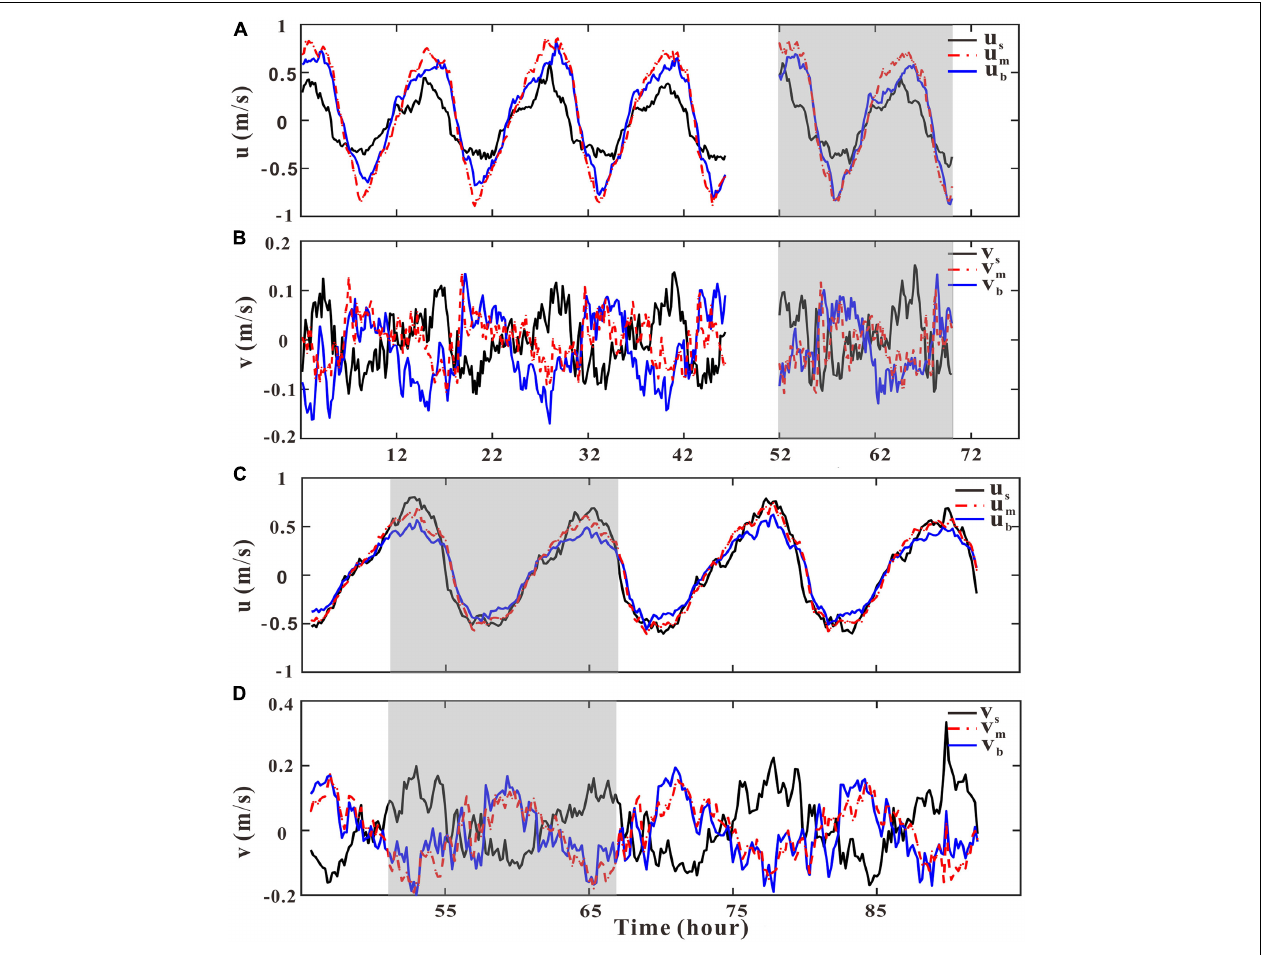
FIGURE 6 | Time series of u and v at the upper (0.75–0.85 h), the lower (0.15–0.25 h), and the mid (0.4–0.5 h) water column at GJ-01 (A,B) and GJ-02 (C,D) . The near-surface, mid, and near-bottom current velocities are shown in black, red, and blue, respectively. The shaded parts indicate the current data measured synchronously at the two